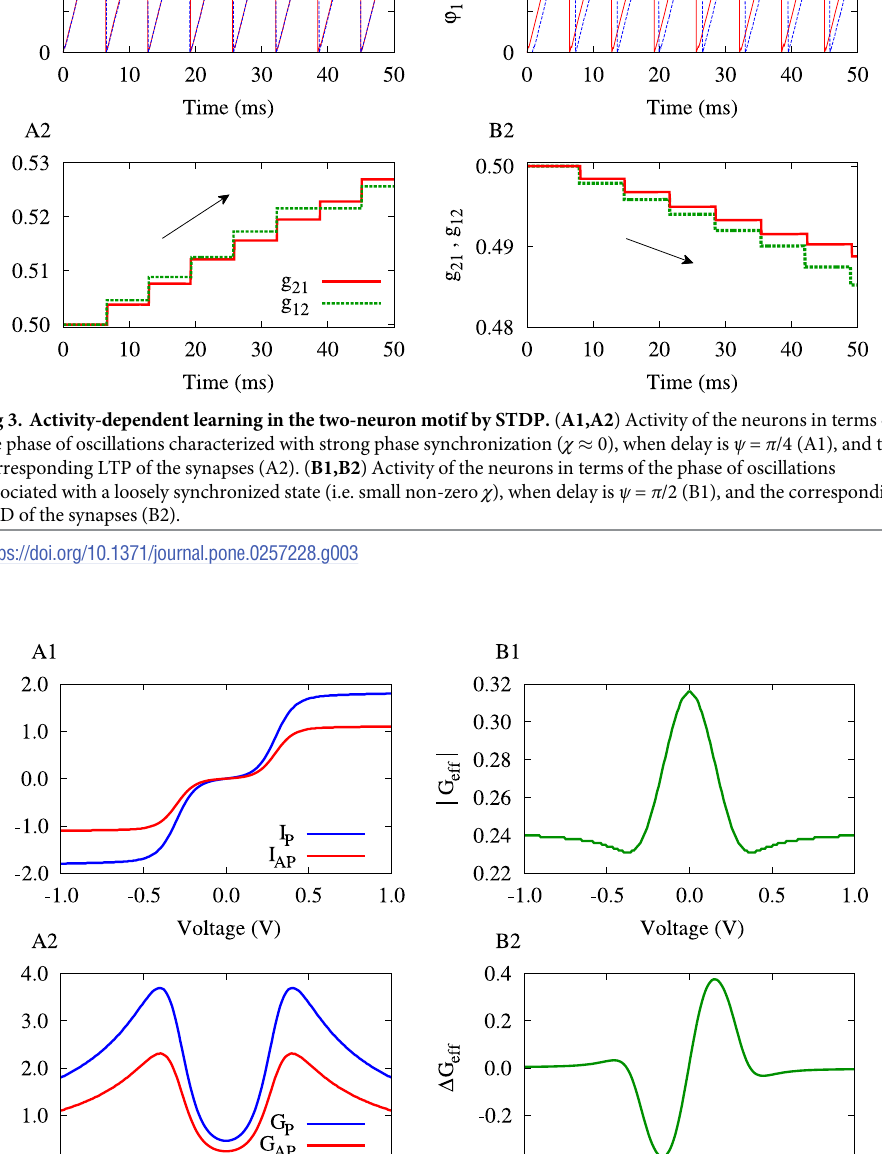
PLOS ONE | https://doi.org/10.1371/journal.pone.0257228 September 10,